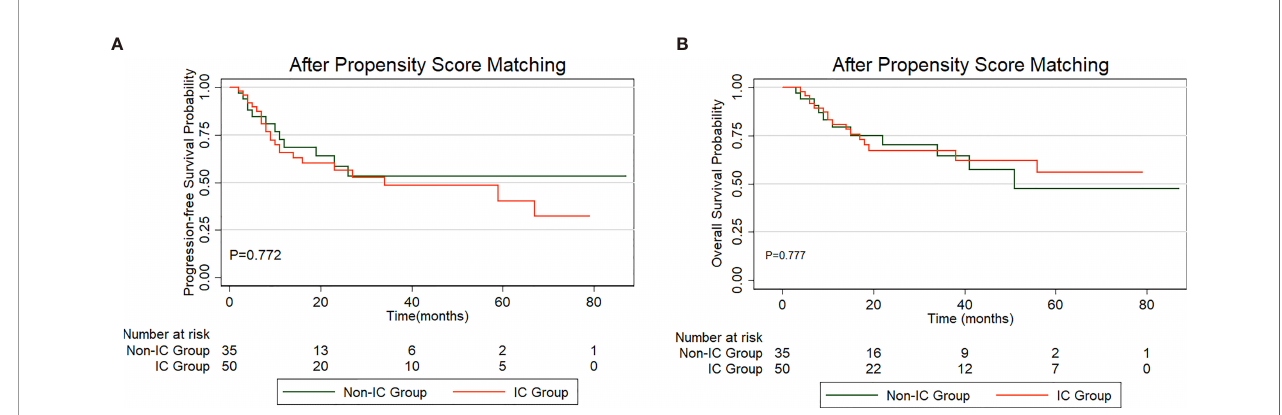
FIGURE 6 | PFS (A) and OS (B) curve for patients treated with induction chemotherapy (IC) versus non-IC in low-risk group after propensity score matching